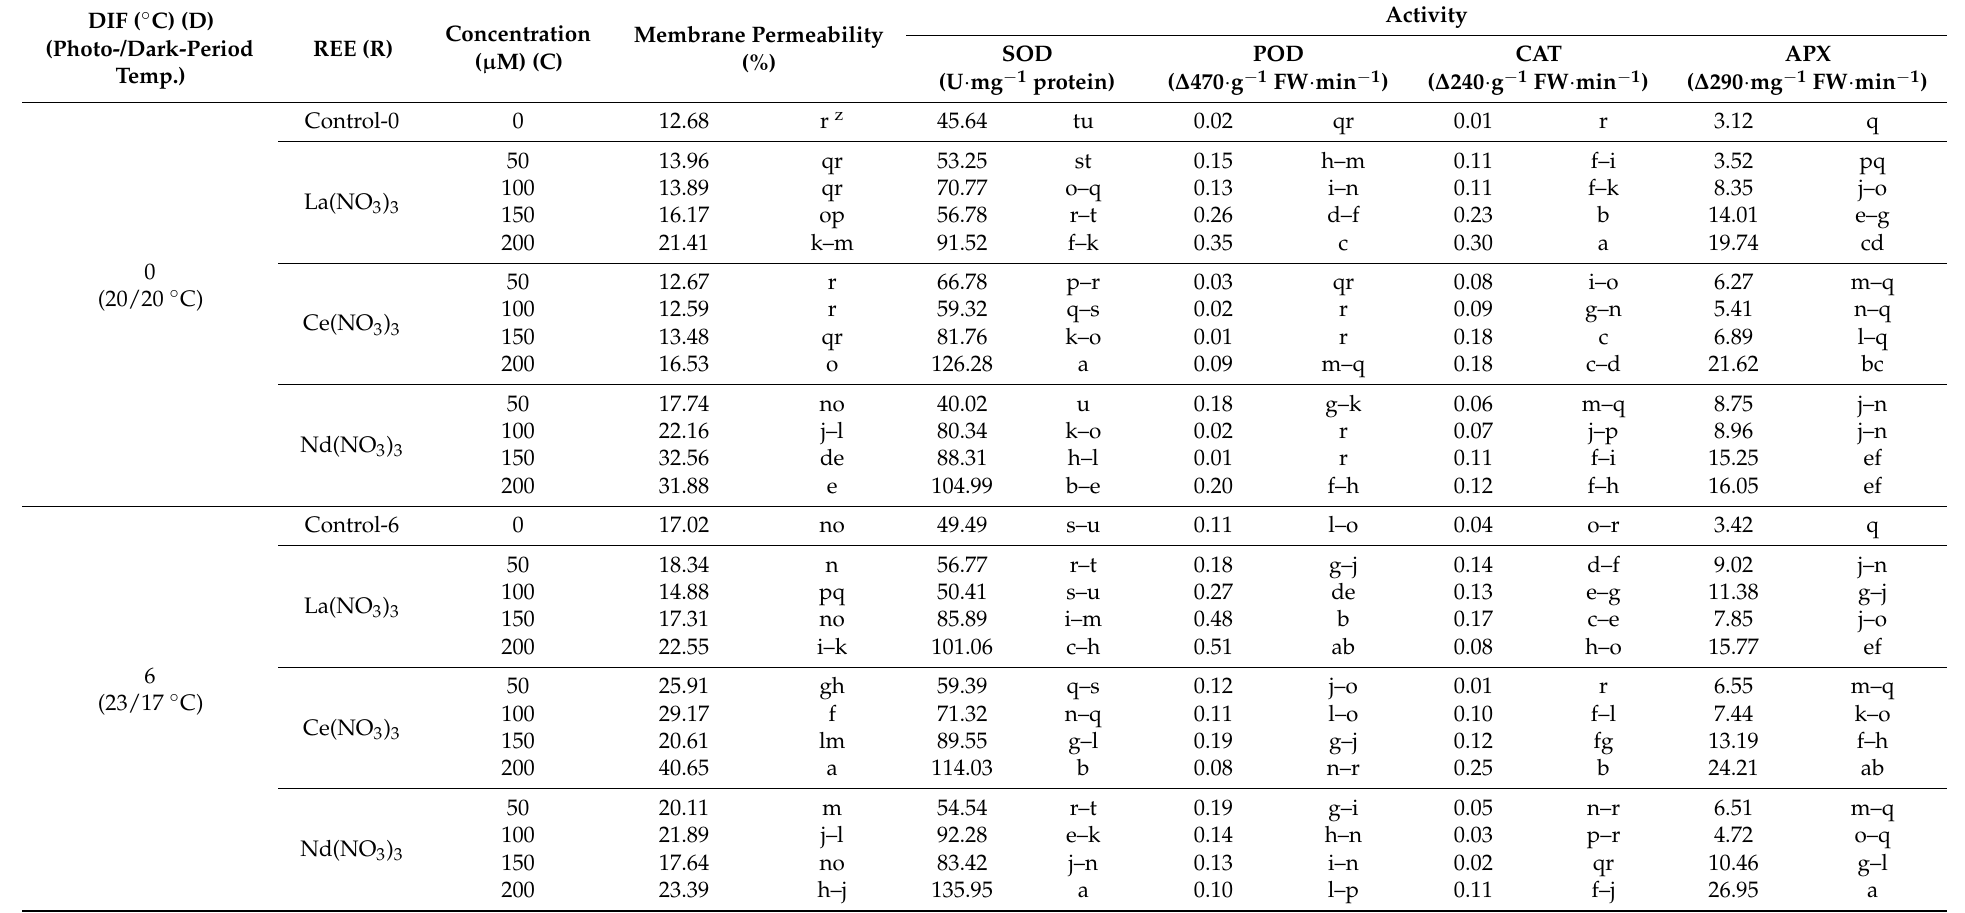
Table 3. Effects of DIF and REE supplementation on the activities of antioxidant enzymes in D. aphyllum